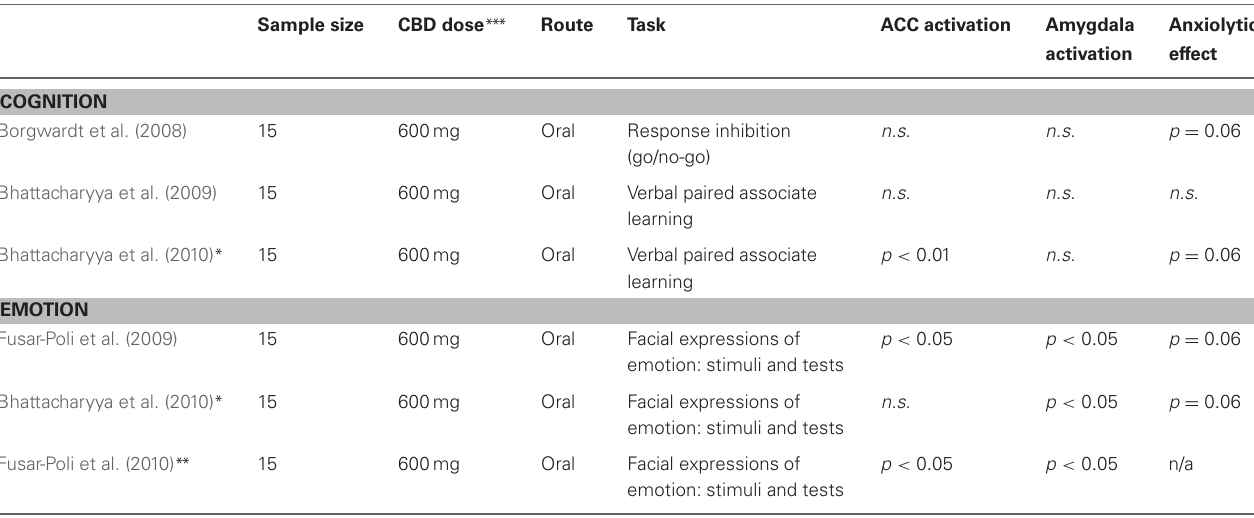
Table 1 | Functional MRI studies of the cognitive and emotional effects of